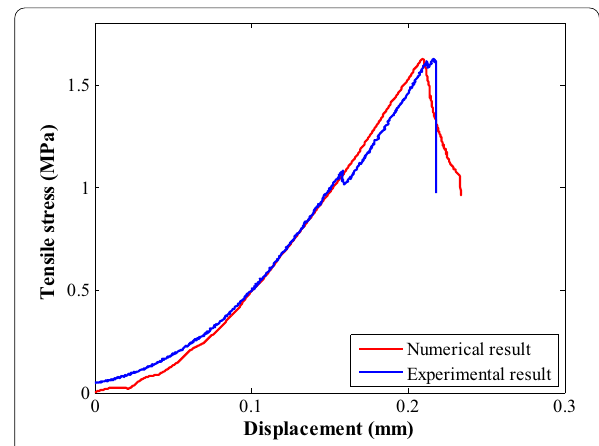
0 Fig. 12 Tensile stress–displacement curve comparison when the water–cement rate was